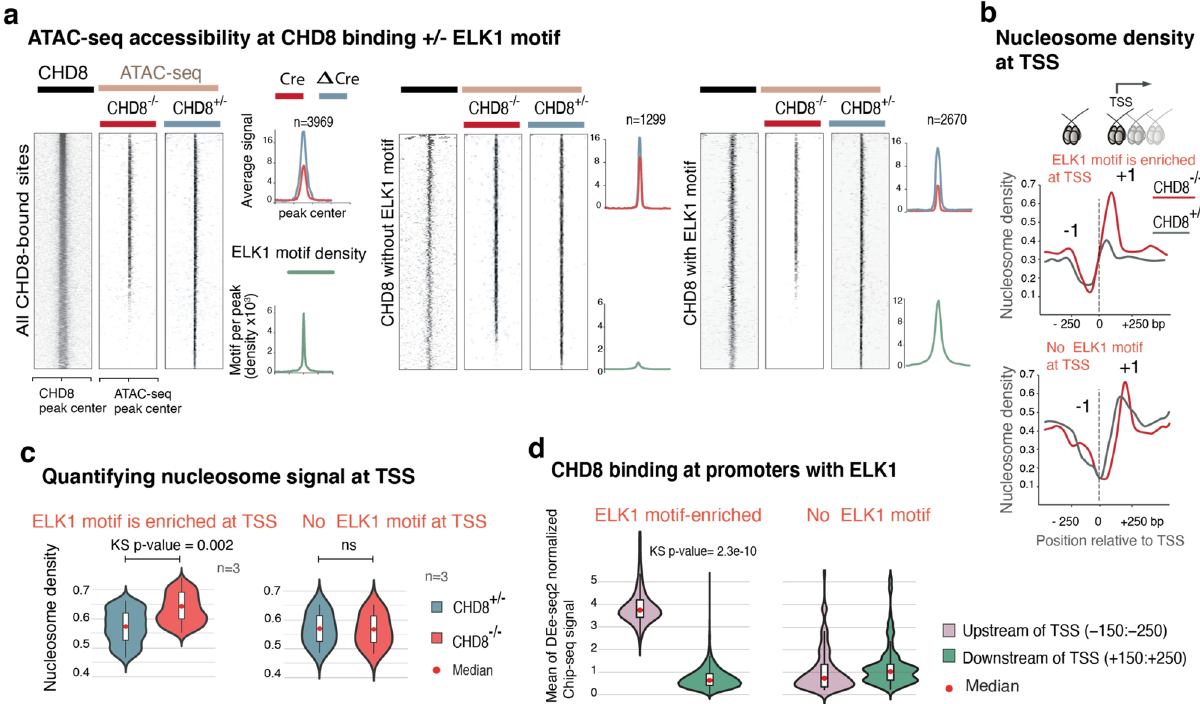
Figure 20. CHD8 and ELK1 cooperate to regulate chromatin accessibility. ( a ) Normalized CHD8 signal and ATAC-seq signal in CHD8 -KO and the control samples plotted, and ELK1 motif density plotted as a green enrichment plot. Genome-wide ChIP-seq and ATAC-seq signal divided into three groups: sites with exclusive enrichment for ELK1 motif, sites without ELK1 motif, and the control sites, which are the randomly shuffled peak sets from control samples. For each group, we compared the ATAC signal from KO to the control sample. ( b ) Cross-correlation analysis of ATAC-seq signal with NucleoATAC to measure nucleosome density. The enrichment plot is a subset of the calculated nucleosome density signal taken from TSS with ± ELK1 (ETS) motif (motif occurrence > 1). ( c ) Violin plots compare normalized and averaged nucleosome density signal at 100 bp region around the position + 1 of TSS with the presence or absence of ELK1 motif. Statistical analysis of distribution comparison is calculated with the Kolmogorov Smirnov test. ( d ) CHD8 binding signal taken from 100 bp upstream and downstream of transcription start sites (TSS), with the presence or absence of ELK1 motif.